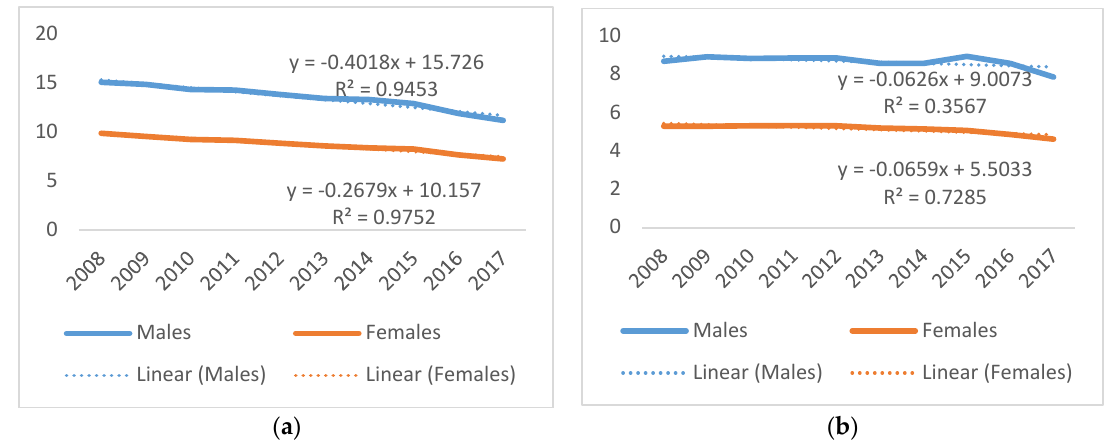
Figure 5. Fatal unintentional drowning rates per 100,000 population and sex, Philippines, 2008–2017: ( a ) 0–4 year olds, males’ and females’ rate and linear trend; ( b ) 5–14 year olds, males’ and females’ rate and linear trend.